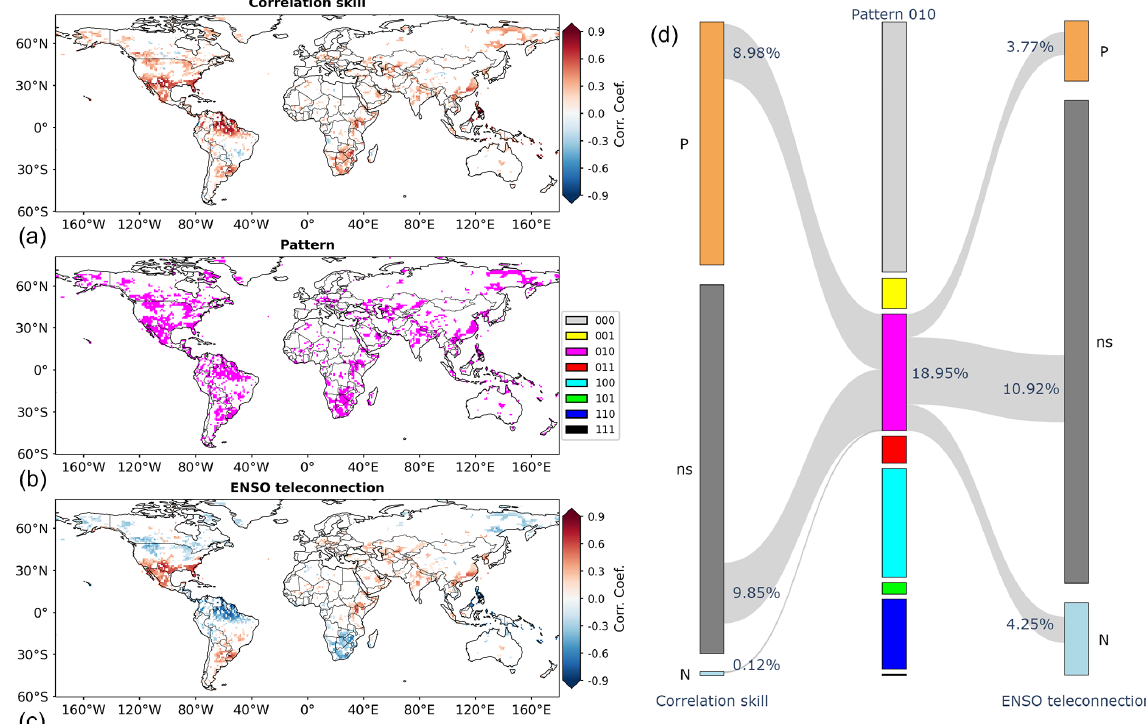
Figure 4. Illustrations of correlation skill (a) and ENSO teleconnection (c) under pattern 010 (b) and the Sankey diagram showing the percentages of grid cells under pattern 010 and the percentages of grid cells exhibiting significantly positive (P), non-significant (ns) and significantly negative (N) correlation skill/ENSO teleconnection (d) . Grid cells under the other patterns are masked and therefore not shown in the spatial plots and the Sankey